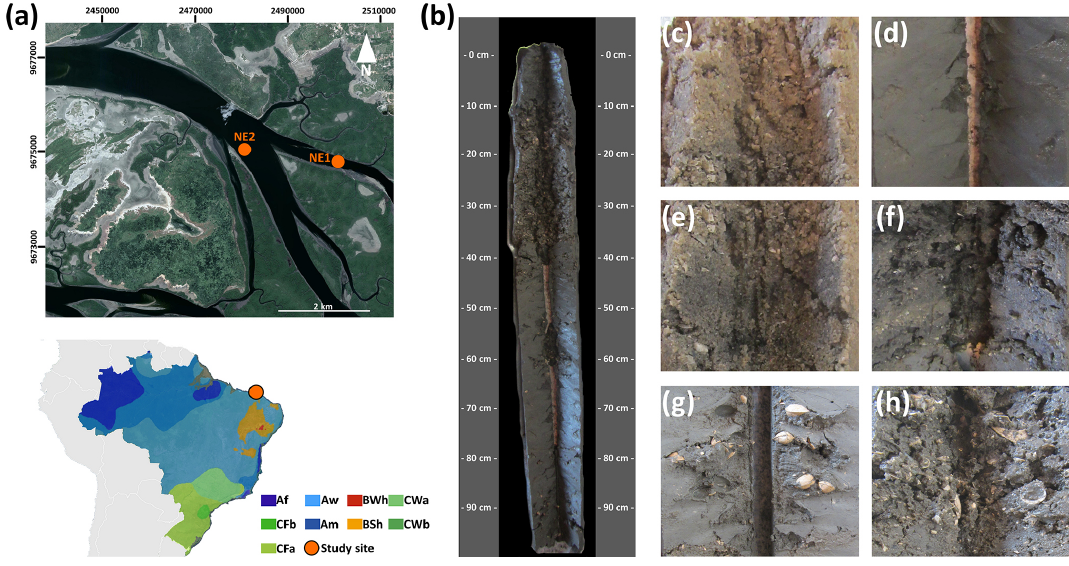
Figure 1. (a) Sampling site location on the northeastern Brazilian coast and the Köppen–Geiger climatic classification of the studied sites (source: Peel et al., 2007). (b) The representative soil profile of the northeastern coast (NE1; soil horizons: Arz 0–10cm, CArz 10–26cm, Crz1 26–37cm, Crz2 37–56cm, 2Crz 56–84cm, 3Crnz 84–114cm) classified as a Eutric Fluvic Reductigleyic Subaquatic Gleysol (Loamic, Hypersalic, Sodic, Hypersulfidic). Detailed images in panels (c) and (d) of the contrast between the massive and single-grained grades in horizons 3Crnz and Crz2, respectively. (e) Coarse soil texture (fine sandy loam) in the Crz2 horizon. (f) Lowermost 3Crnz horizon with black-colored spots in the soil matrix due to metal sulfides. Panels (g) and (h) show intact and fragmented seashells in the Crz1 soil